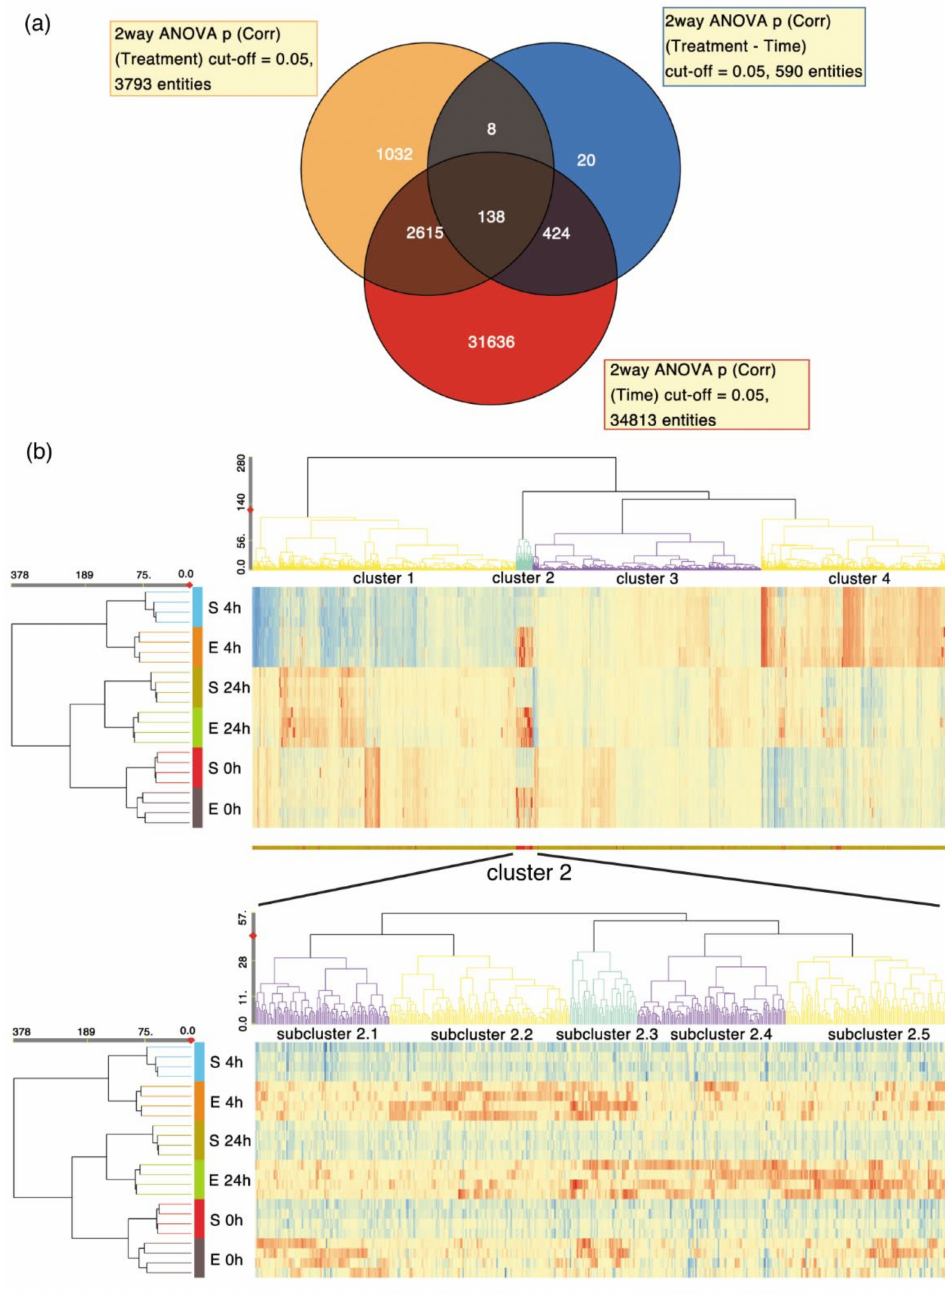
Figure 7. Transcriptome analysis of TM3 cells. S: sham-exposed cells. E: nsPEF-exposed cells. ( a ) Venn diagram for groups of differentially expressed genes identified by a two-way ANOVA with interaction (independent variables: treatment and time; p < 0.05). Orange circle: treatment-dependent differentially expressed genes. Red circle: time-dependent differentially expressed genes. Blue circle: treatment- and time-dependent differentially expressed genes. ( b ) Upper panel: unsupervised hierarchical clustering performed for all differentially expressed genes identified by ANOVA. Red colour indicates a relatively higher gene expression, and the blue, a relatively lower gene expression. Clustering on genes and conditions. Similarity measure: Euclidean. Linkage rule: Ward’s. Four main gene clusters are indicated in different colours. Lower panel: close-up of cluster 2 showing five subclusters of genes with a higher expression in nsPEF-exposed